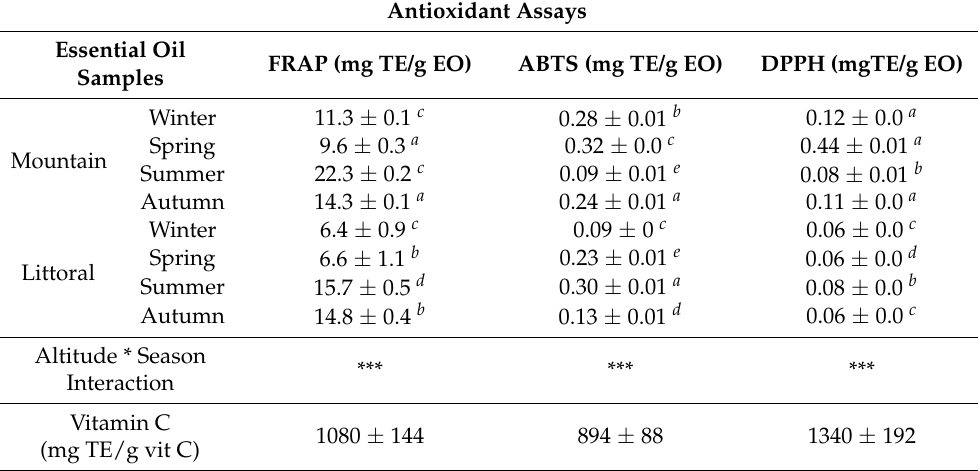
Table 2. Evaluation of the antioxidant activities of Pistacia lentiscus essential oils using FRAP, ABTS, and DPPH